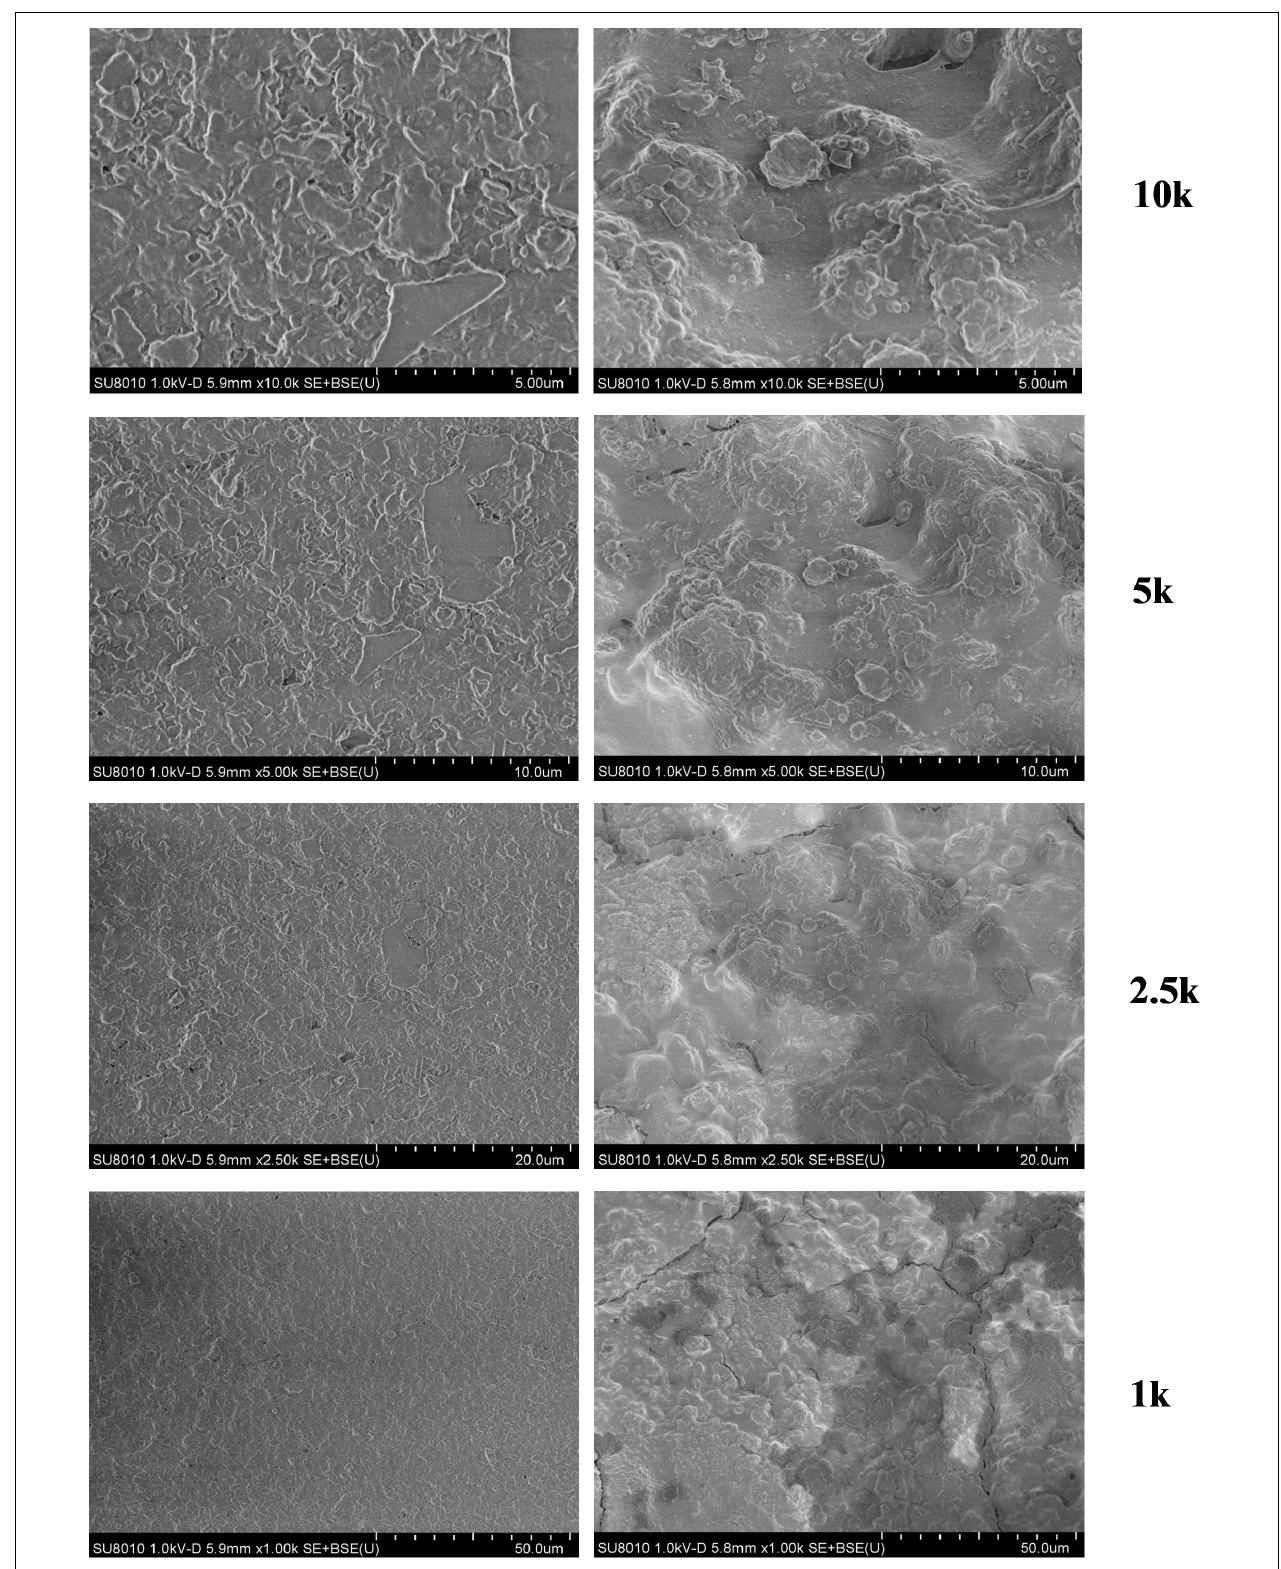
FIGURE 5 | SEM photos of the inner surfaces of normal shells and shells with spots. 1k, 1000 × ; 2.5k, 2500 × ; 5k, 5000 × ; and 10k, 10,000 × magnification.